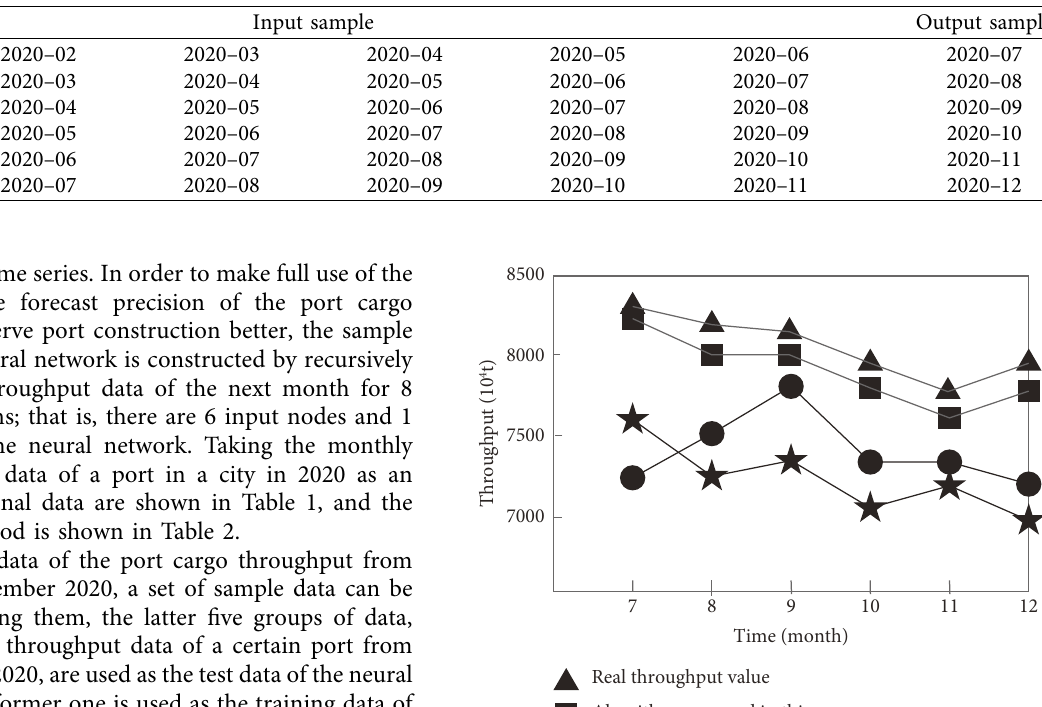
Table 2: Sample data construction method.